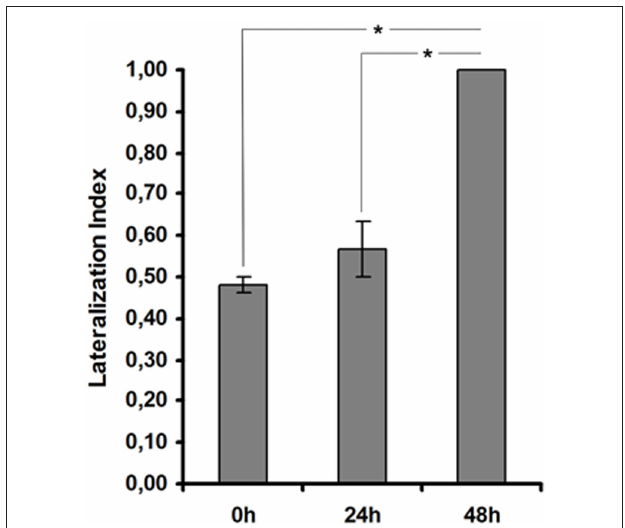
FiguRE 3 | Lateralization of avoidance movement during food aversion reflex formation in Helix lucorum . Forty-eight hours after training, Helix demonstrates lateralization of avoidance movement. An index to quantify lateralization of avoidance movement was calculated using R /( L + R ), where R represents the number of animals, which moved to the right while avoiding carrot, and L the number of animals, which moved to the left while avoiding carrot. n = 18 (three series, six animals in every series) for all groups. * p < 0.001. Errors bars =